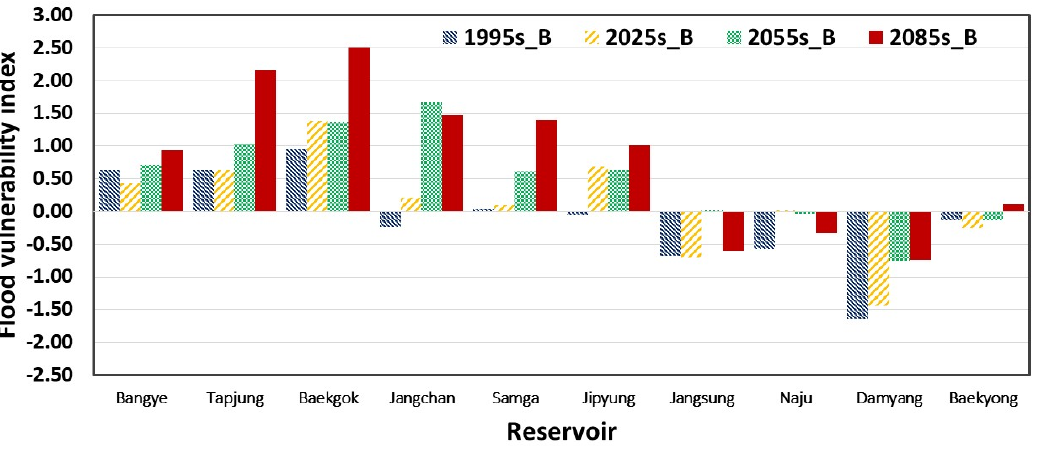
Figure 6. Calculation results of flood vulnerability indices for ten reservoirs before dam heightening under climate change. B stands for before dam heightening